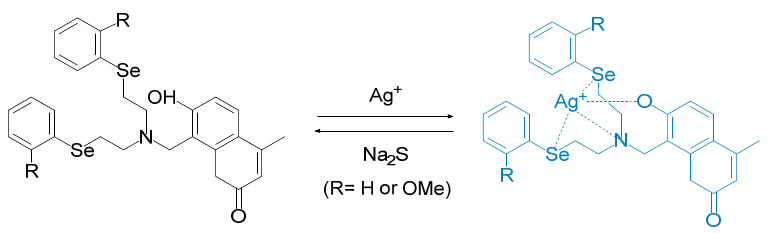
Figure 35. Structures of SC1 and SC2 by Su et al. and their reaction with Ag + and Na 2 S.